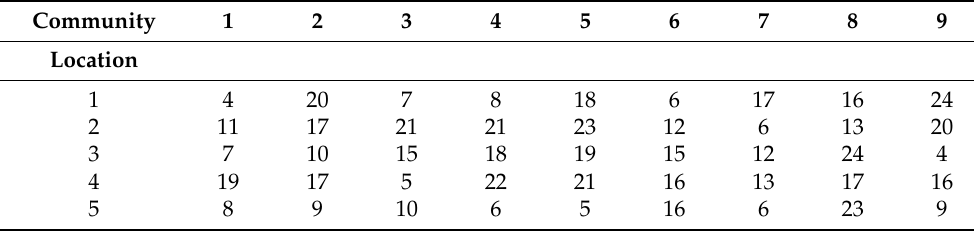
Table 2. Traveling time of time t of the location i to locate the EMS j .